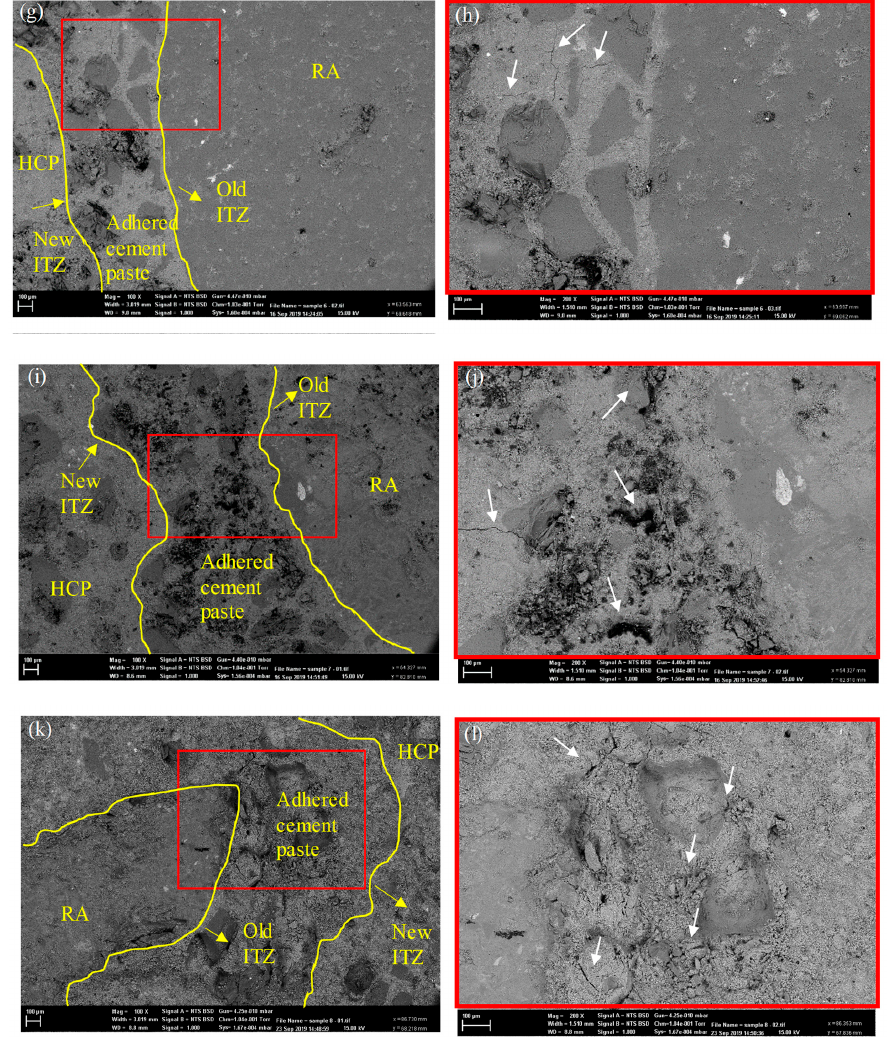
Figure 12. SEM images of ( a , b ) C.S, ( c , d ) 100RAS0, ( e , f ) 100RAS1 ( g , h ) 100RAS2, ( i , j ) 100RAS3 and ( k , l ) 100RAS4 mixes (in different magnifications). The SEM images of the 100RAS1, 100RAS2, 100RAS3, and 100RAS4 samples are shown in Figure 12e–l. As indicated by the arrows, minimal micro-cracks were found in the microstructure and ITZs of 100RAS1 and 100RAS2 samples when compared to the unscreened sample. In the 100RAS1 and 100RAS2 samples, the microcracks are predomi- nantly single, with very little networking. The crack development through the attached old cement mortar is visible in the SEM images of the 100RAS3 (Figure 12i,j). However, the detected cracks were mostly single, with only a few cracks networking.